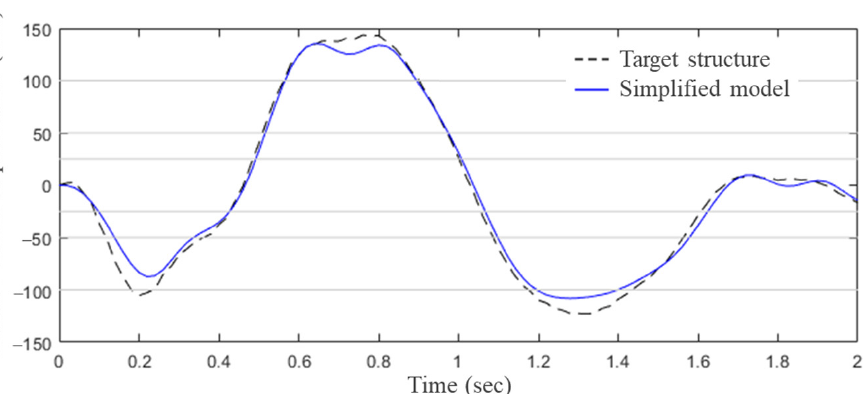
Figure 11. Specifications of the control points. Relative lateral displacement between the upper and lower ends of the damper under sine-function loading with maximum 0.2 g acceleration.